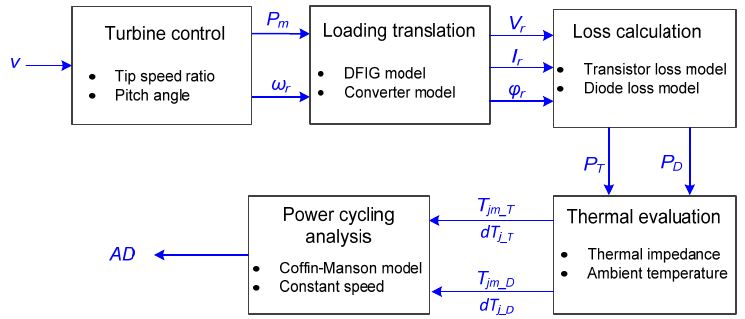
Figure 4. Flow chart to estimate the lifetime of rotor-side converter from wind speed v to accumulated annual damage (AD) in the wind turbine.